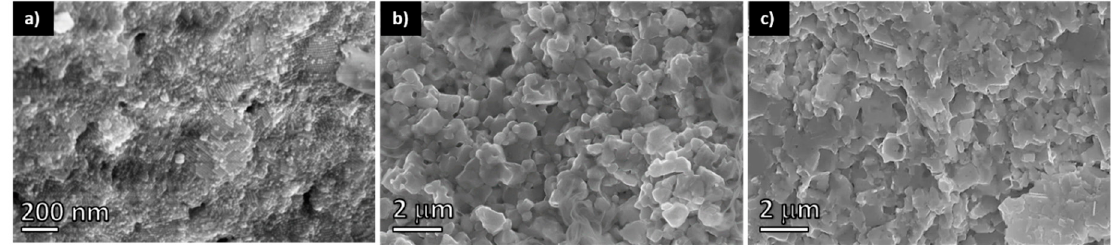
Figure 3. SEM micrographs of: ( a ) PbS nanopowder after ligand exchange; ( b ) PbS consolidated pellet; and ( c ) Pb 0.9 Sb 0.1 S consolidated pellet.